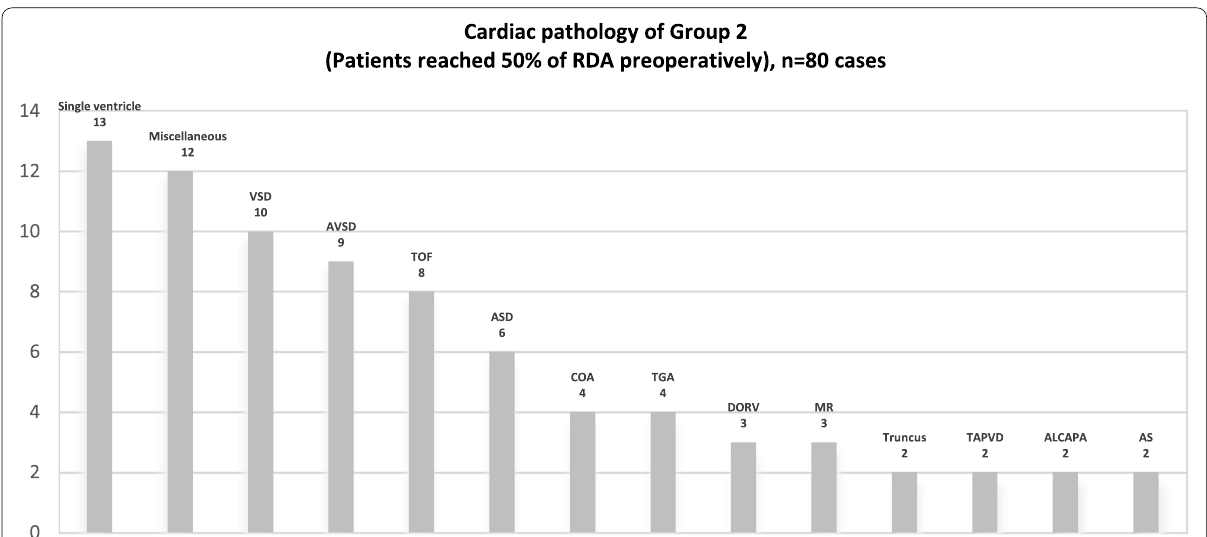
Fig. 2 Cardiac pathology for group 2: VSD, ventricular septal defect; TOF, tetralogy of Fallot; ASD, atrial septal defect; AVSD, atrio ventricular septal defect; COA, coarctation of the aorta; TGA, transposition of great vessels; DORV, double outlet right ventricle; MR, mitral regurge; IAA, interrupted aortic arch; TAPVD, total anomalous pulmonary venous drainage; AS, aortic stenosis; ALCAPA, abnormal left coronary artery from pulmonary